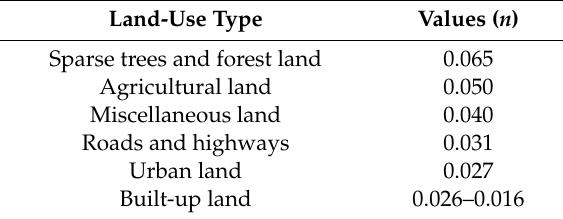
Table 3. Value of the Manning roughness ( n ) for di ff erent land-use types